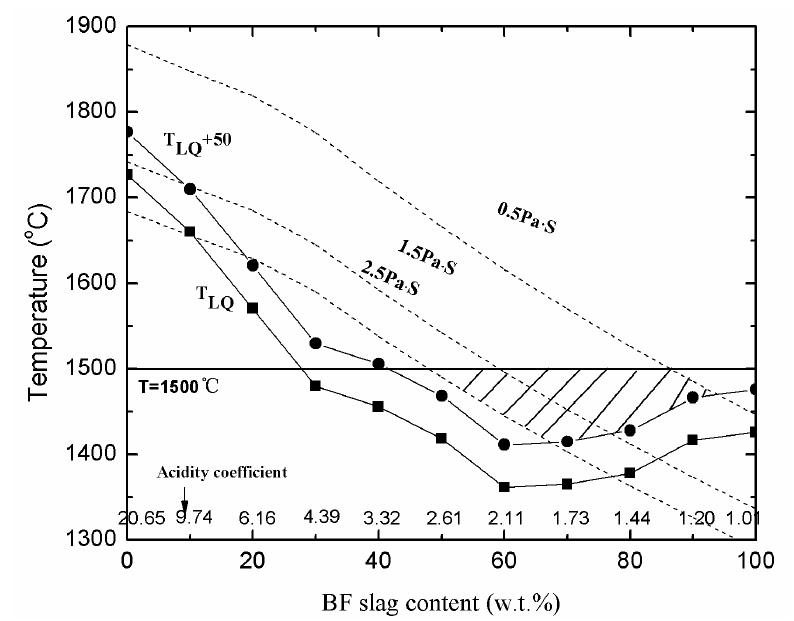
Figure 3. Liquidus temperature of the samples.